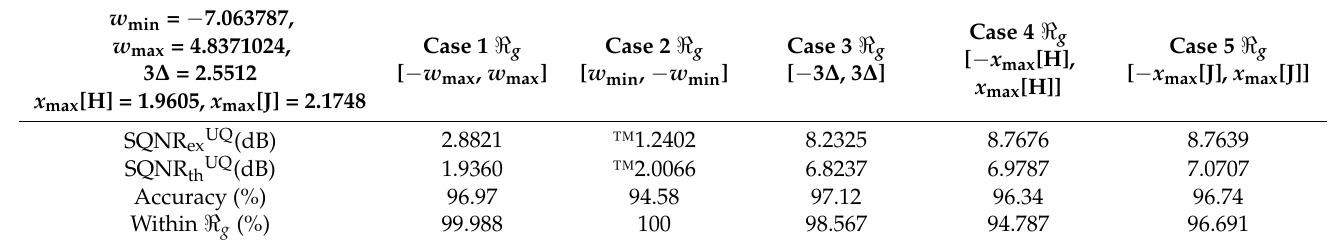
Table 4. SQNR and QNN model’s accuracy for MLP trained on MNIST dataset with the application of different UQ designs for bit rate of R = 2 bit/sample (part of the results are from